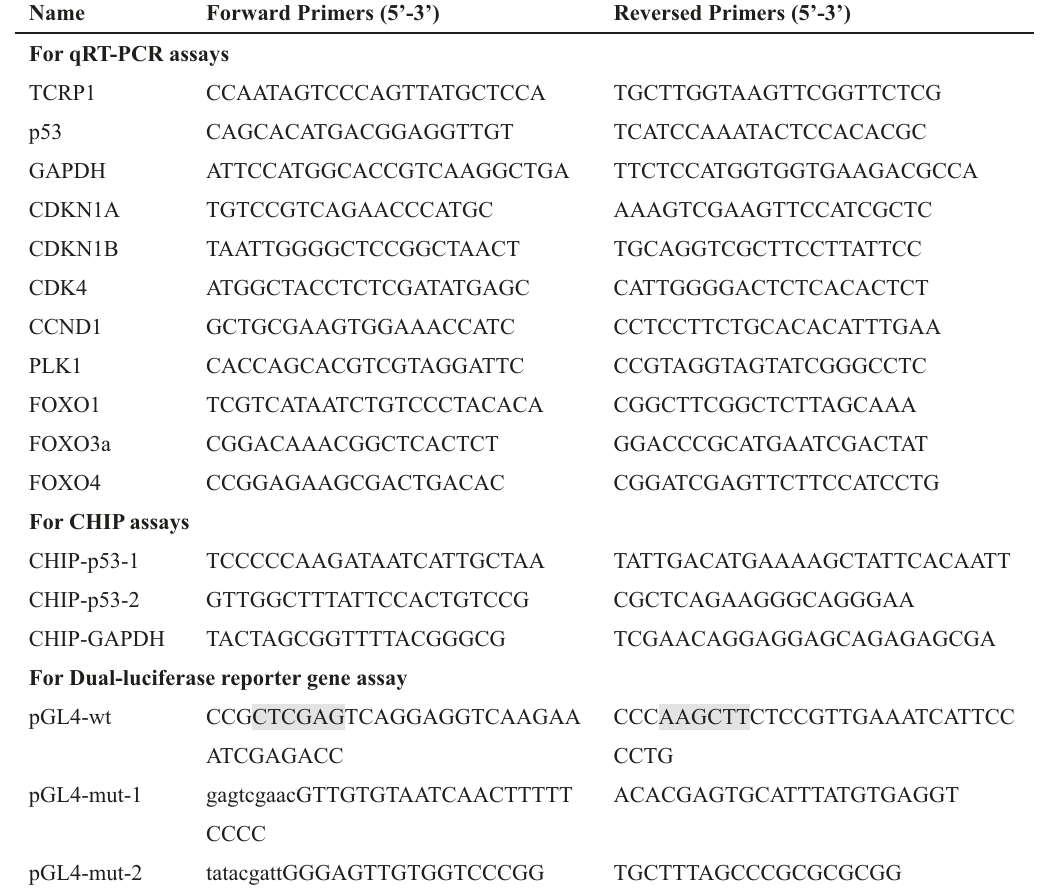
Table 1. Summary of primers in this